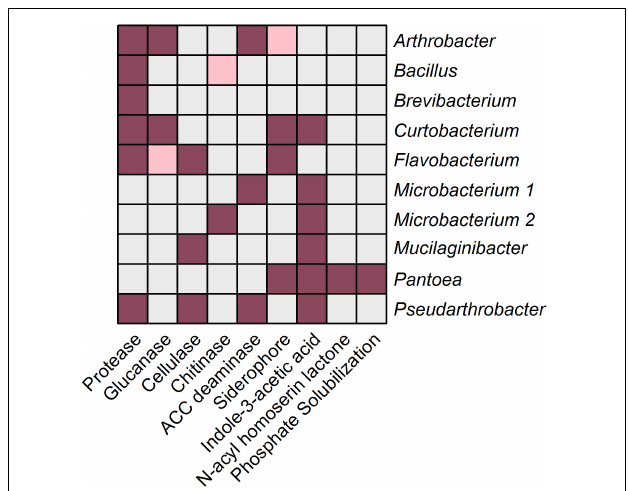
FIGURE 7 | In vitro functional characteristics of bacterial isolates obtained from the rhizosphere microbiome transplant. Ten representative bacterial isolates obtained from the rhizosphere microbiome transplant were tested in vitro for their potential plant beneficial characteristics in different bioassays described in the section “Materials and Methods.” Gray color represents a negative result, pink color represents a slight positive result and violet color represents a positive result.